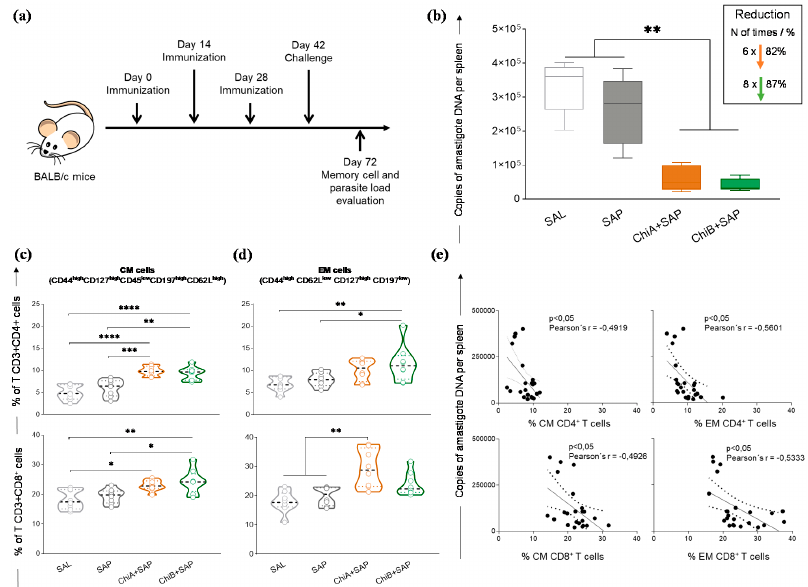
Figure 5. Parasite burden and generation of memory cells in the spleen of immunized mice with chimeric vaccines and challenged with L. infantum . ( a ) BALB/c mice were immunized three times and challenged with L. infantum promastigotes. Four weeks later, they were sacrificed for further analyses. ( b ) Parasite burden was assessed in the spleen using quantitative PCR and results are expressed in amastigote DNA copies per spleen. ( c ) Violin plots represent the percentage of central memory T cells (CD3 + CD4 + or CD8 + CD127 high CD44 high CD45RA low CD62L high C197 high ) and ( d ) effector memory T cells (CD3 + CD4 + or CD8 + CD62L low CD44 high CD127 high C197 low ) in mice splenocytes after in vitro stimulation with SLA. ( e ) Correlation analyses between parasite load and frequency of T CD4 + and CD8 + central memory (CM) and effector memory (EM) cells are shown by Pearson´s r . Data on the graphs are represented as means ± SD of two independent experiments ( n = 8) and p -values represent the difference between the groups: * p- value < 0.05, ** p- value < 0.005, *** p- value < 0.0005, and **** p- value < 0.0001.